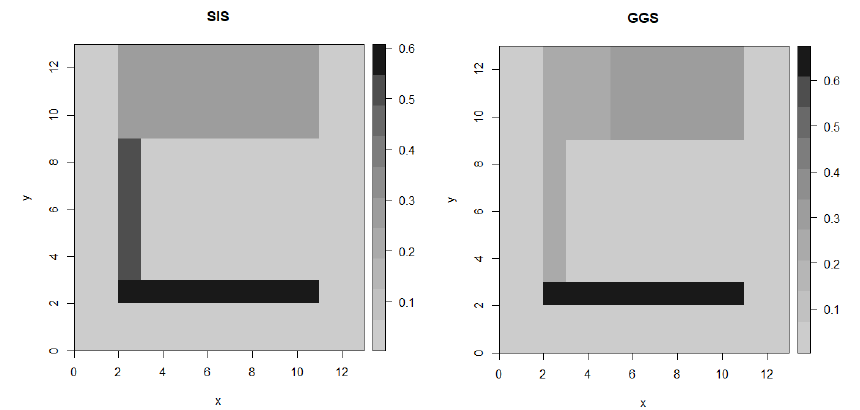
Figure 12. Surface profiles as determined by the GGS and the SIS